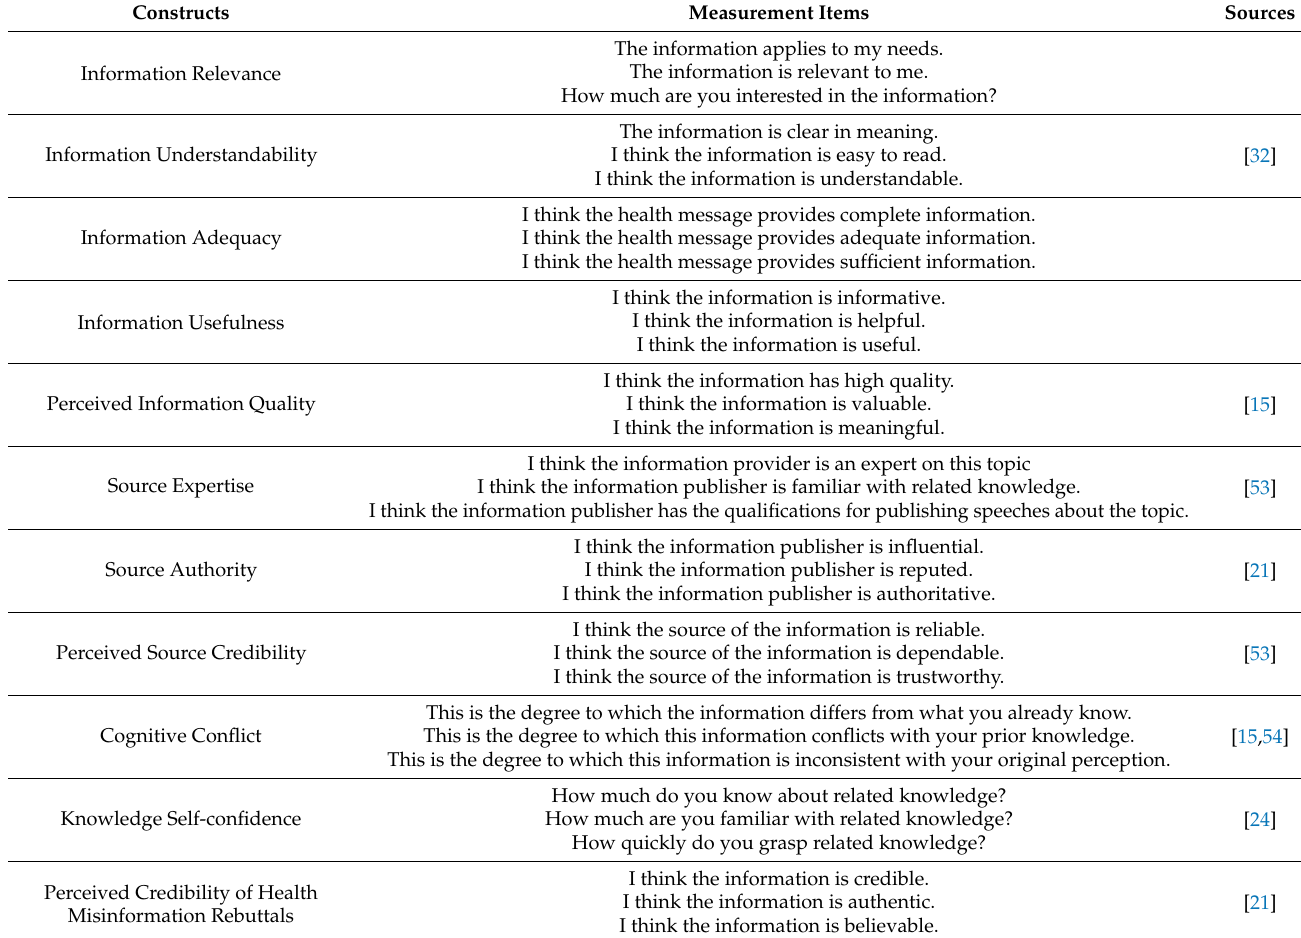
Table 1. Measurement items and